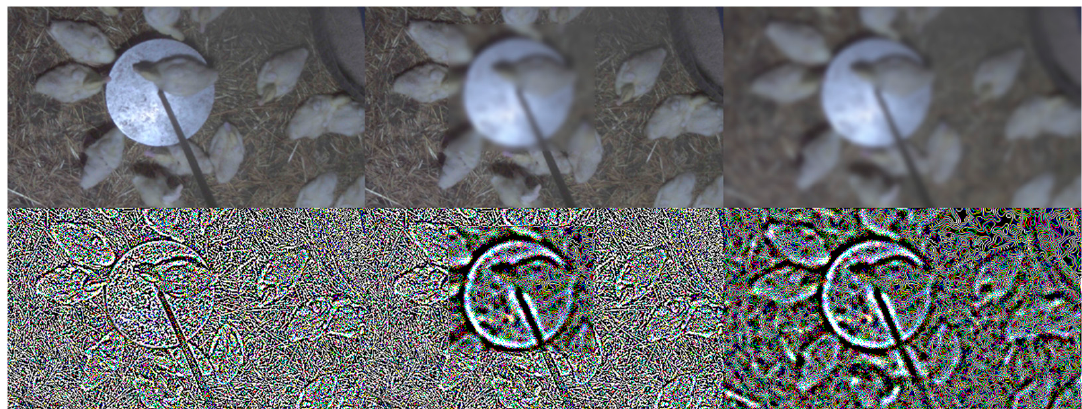
Figure 7. Artificial blur.